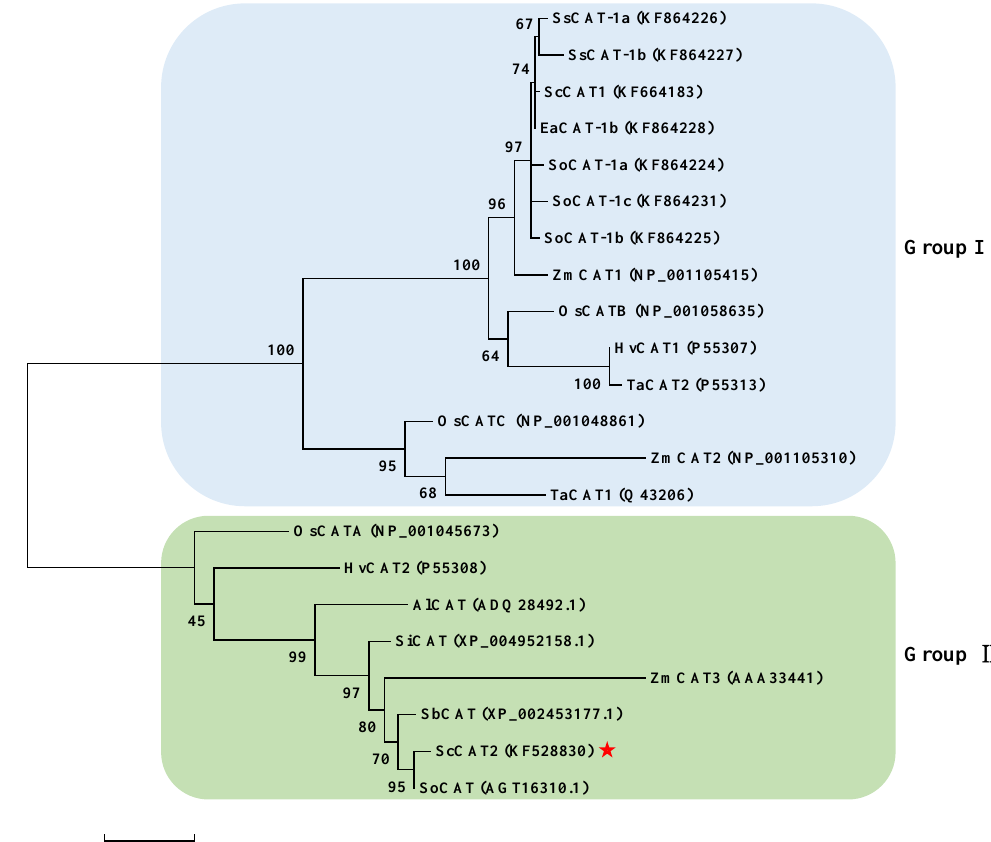
Figure 3. Phylogenetic reconstruction of ScCAT2 with catalases from sugarcane and other plant species. The maximum-likelihood method with 1000 bootstrap replication was used. Zm, Zea mays ; Os, Oryza sativa ; Hv, Hordeum vulgare ; Ta, Triticum aestivum ; Sb, Sorghum bicolor ; Si, Setaria italic ; Al, Aeluropus littoralis ; So, Saccharum officinarum ; Ss, Saccharum spontaneum ; and Ea, Erianthus arundinaceus . ScCAT2 was marked with a red asterisk.